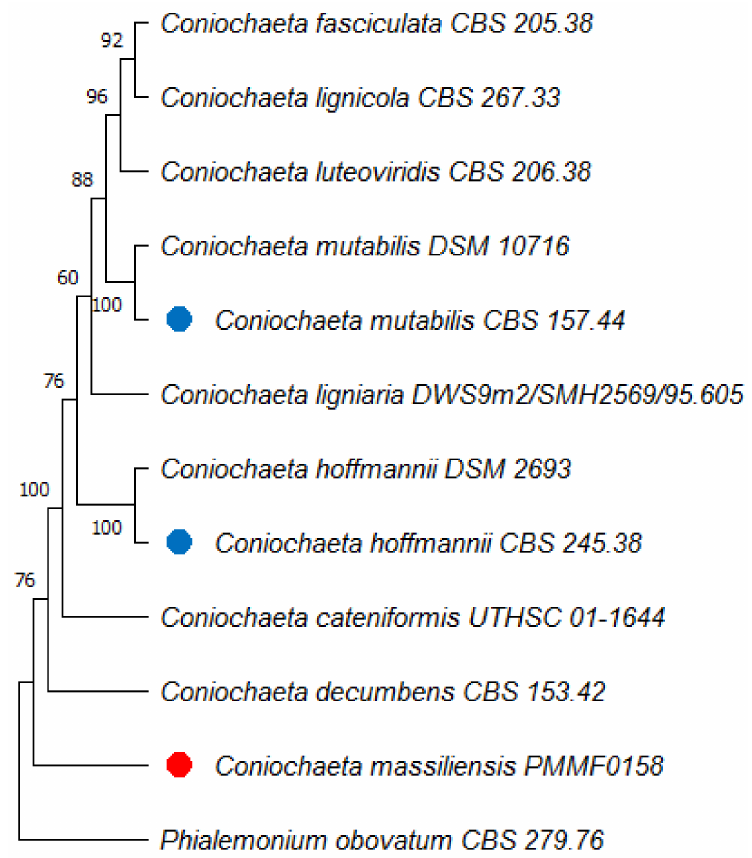
Figure 6. Multilocus phylogenetic tree of the newly isolated species Coniochaeta massiliensis PMML0158 (indicated with red dots) and 11 reference strains (type strains are indicated with blue dots), based on the concatenated ITS, B-tub2, and D1/D2 sequences. Phialemonium obovatum CBS 279.76 was used as an outgroup. The maximum-parsimony tree was generated using the MEGA 11 software, with 1000-replication bootstrap